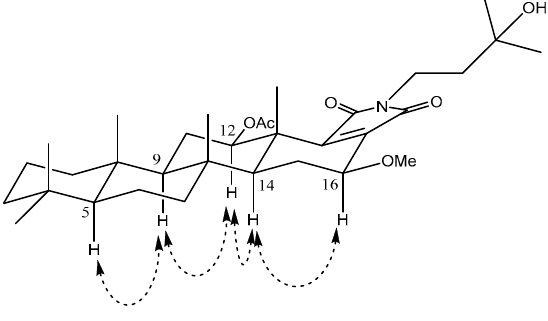
Figure 3. Key NOESY correlations of 1.